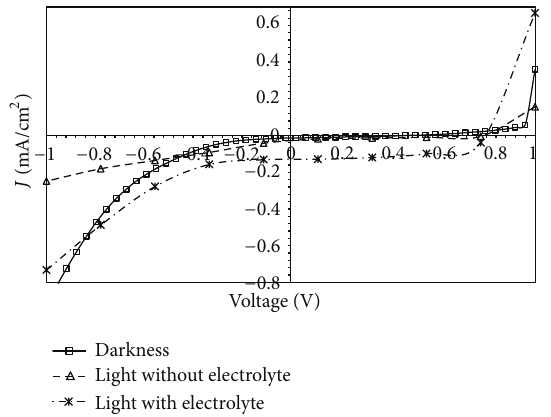
Figure 2: 𝐽 - 𝑉 curves of ITO/EB-MWCNT/ZnO-riboflavin/ITO structure under darkness and illumination and with and without electrolytes.